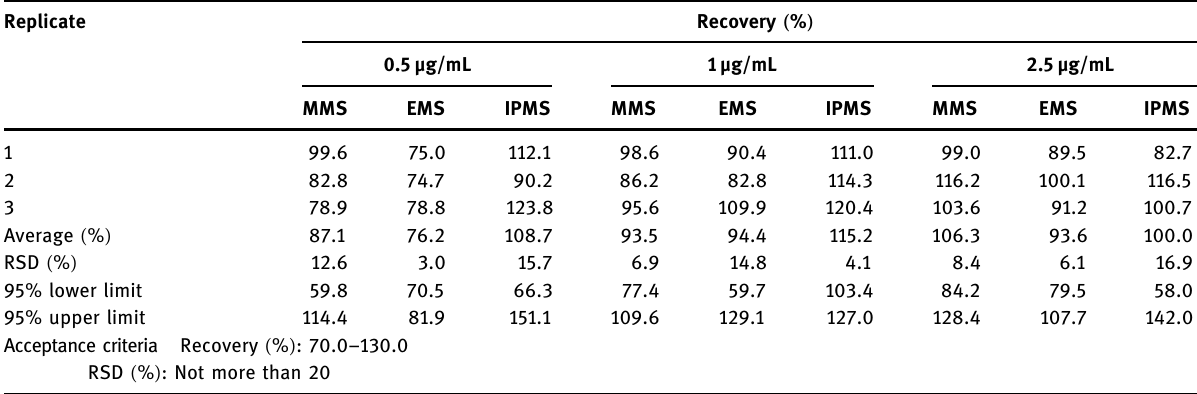
Table 3: Recovery of MMS, EMS, and IPMS at 0.5, 1, and 2.5 µg/mL ( equivalent to 1, 2, and 5 ppm in the delgocitinib drug substance ) obtained in triplicate